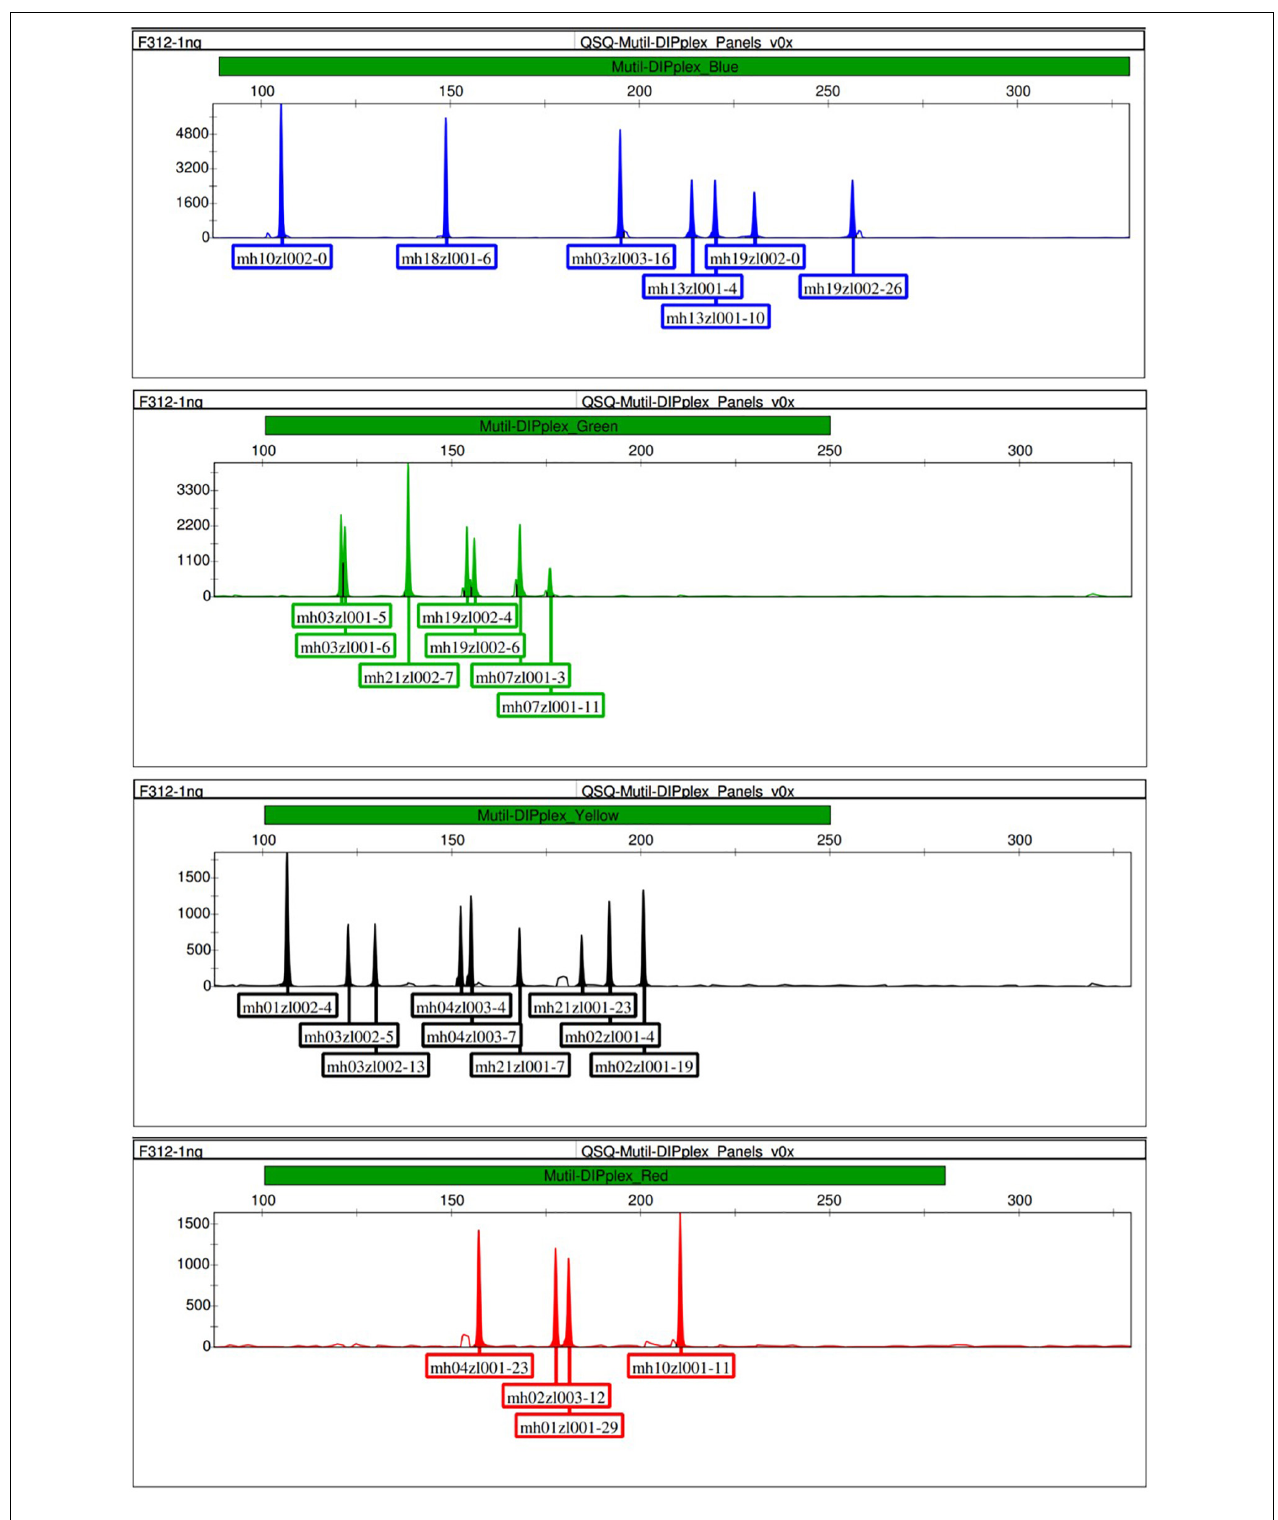
FIGURE 1 | Representative electropherogram of control DNA F312 amplified at 1